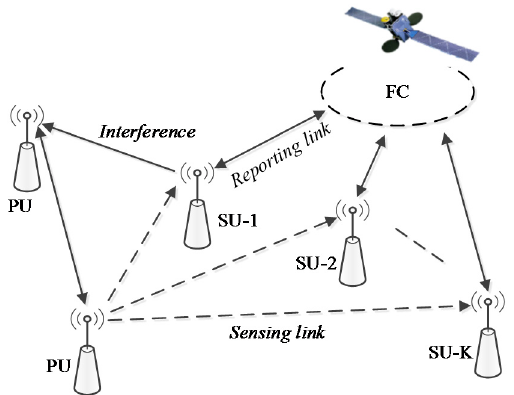
Figure 1. The system model of the CSS (cooperative spectrum sensing) for LEO (low earth orbit) mobile satellite services.